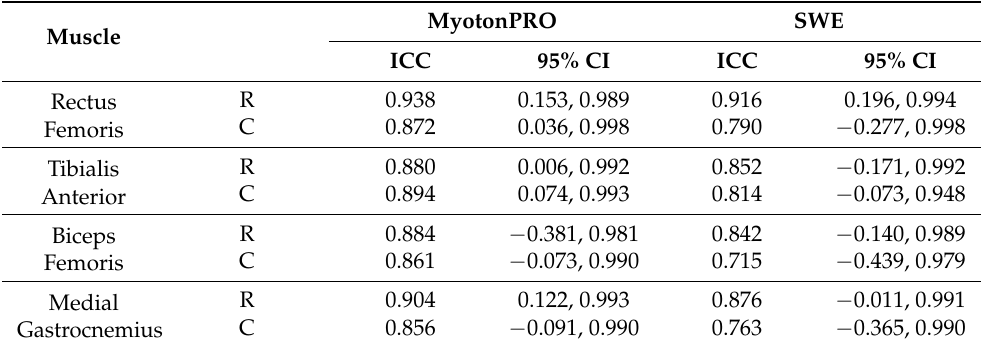
Table 4. Intra-rater reliability of MyotonPRO and SWE in measurements of muscle